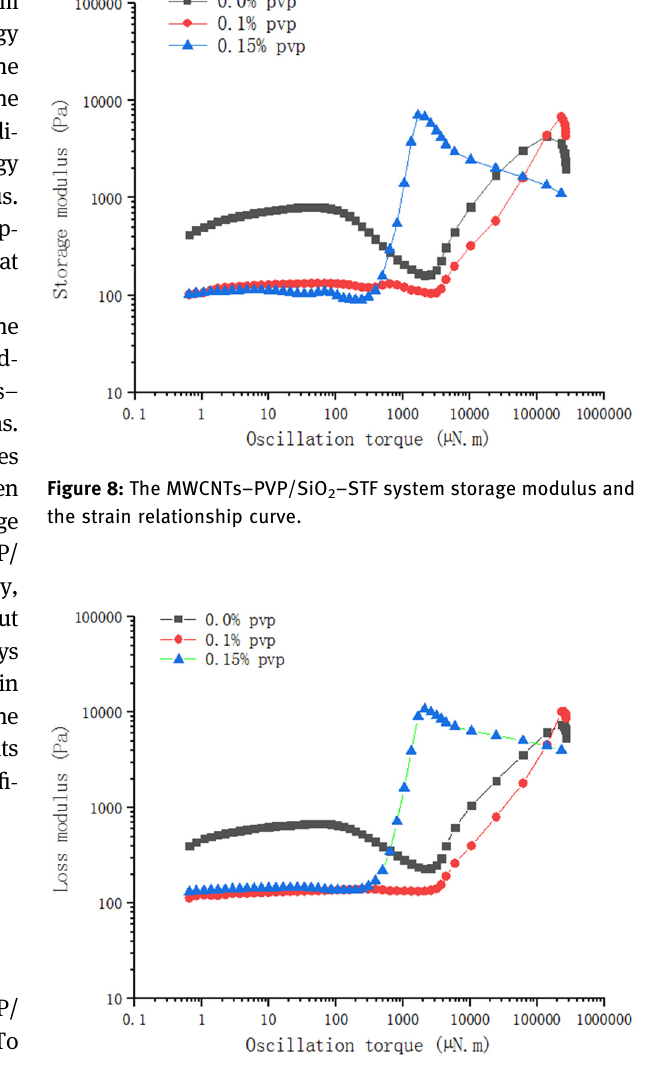
Figure 9: The relationship between the energy dissipation modulus and the strain on the MWCNTs – PVP/SiO 2 – STF